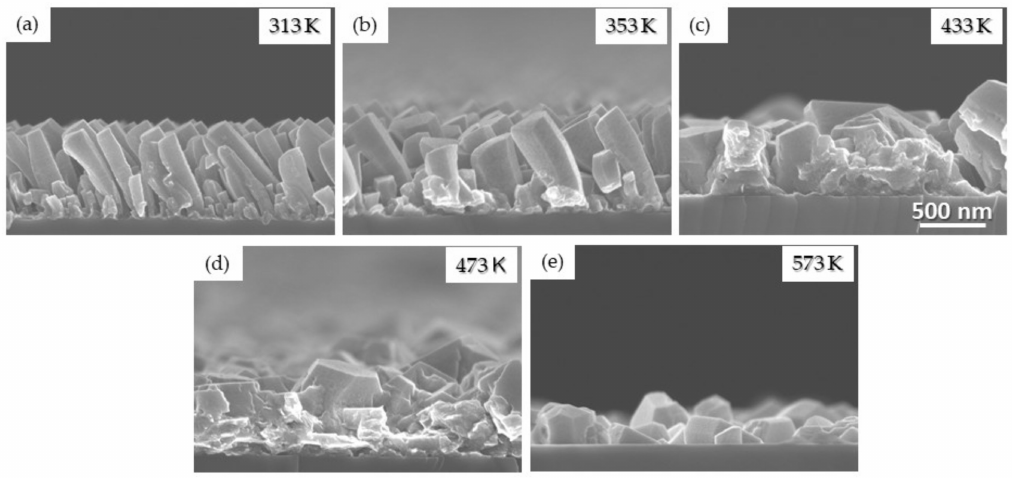
Figure 9. Mg thin films synthesized at 50 W, 0.26 Pa, and 85 ◦ for various substrate temperatures: ( a ) 313; ( b ) 353; ( c ) 433; ( d ) 473; ( e ) 573